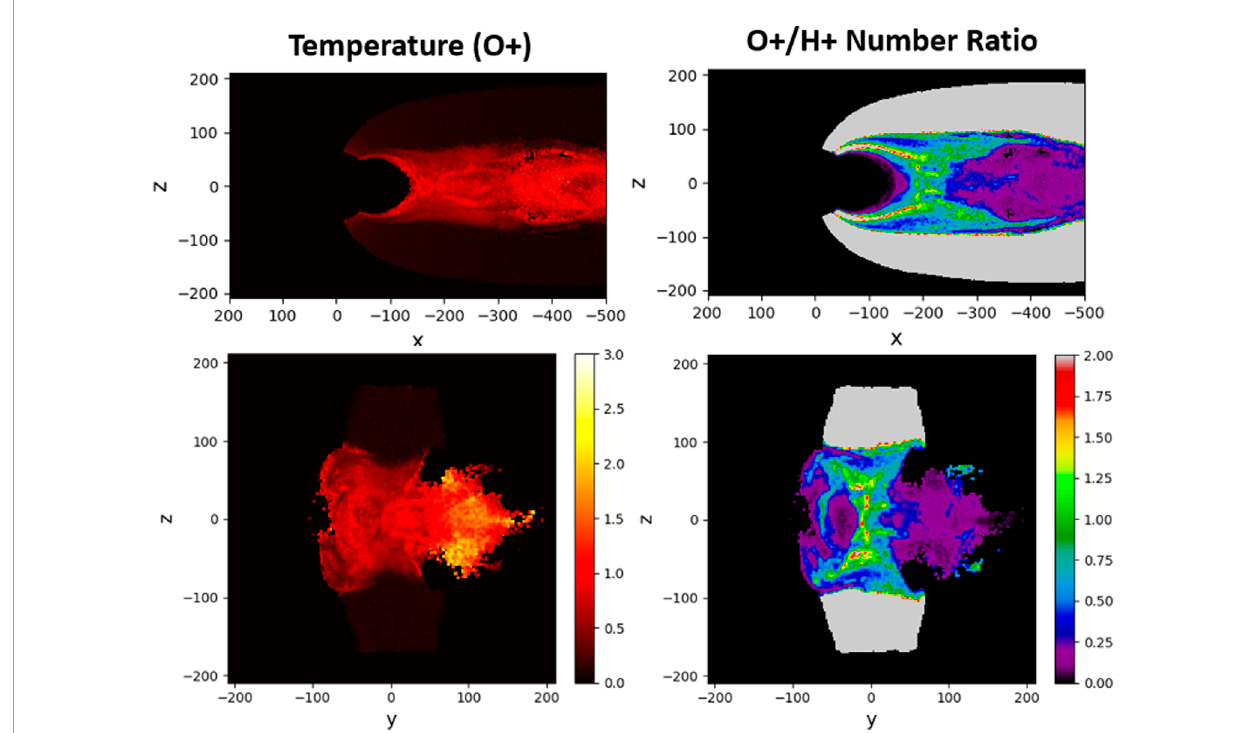
FIGURE 4 O+ temperature and O+/H+ number ratio in two cross-sections in the first lobe outflow simulation at Ω cp t = 461: x-z ( y = 1 d i ) and y-z ( x = − 199 d i ) .